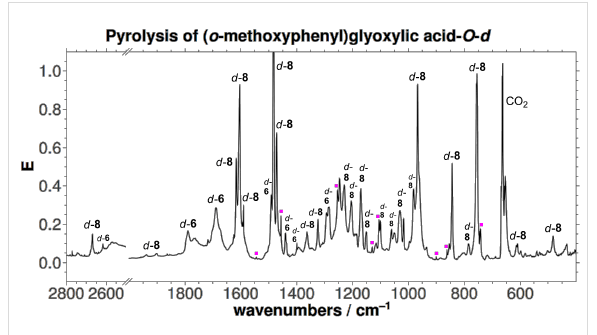
Figure 2: Unmodified matrix IR spectrum (Ar, 11 K) of the pyrolysis (600 °C) of d - 5 . Traces of 9 are indicated by magenta